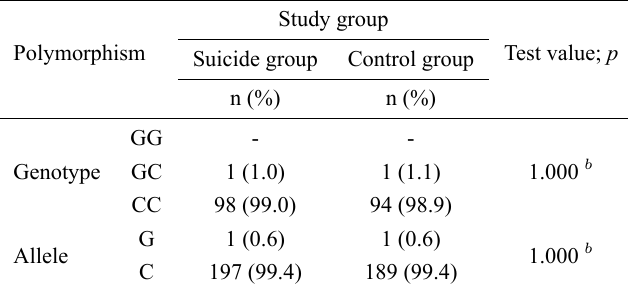
Table 8. Comparison of study groups in terms of SLC6A4 gene rs6355 polymorphism.